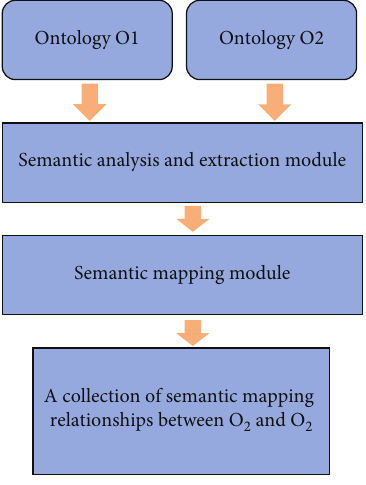
Figure 1: Logistic ontology mapping